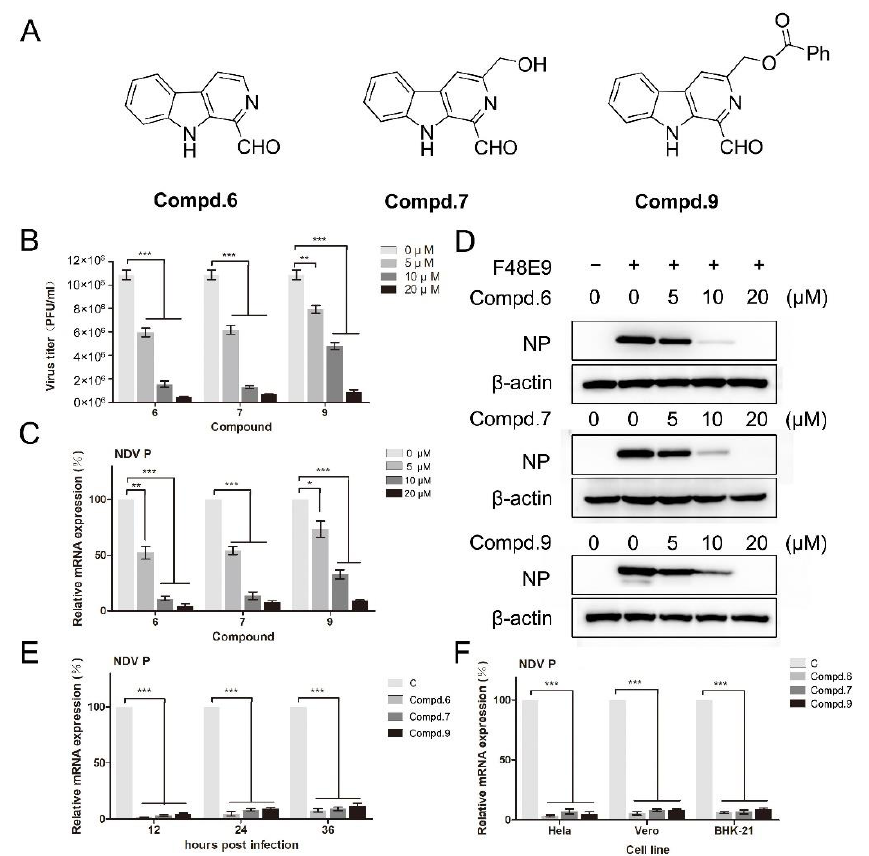
Figure 1. 1-formyl- β -carboline derivatives inhibit the NDV proliferation in a dose-dependent manner. ( A ) Molecular structures of compounds 6 , 7 , and 9 . ( B – D ) DF-1 cells were infected with F48E9 (MOI = 0.01). After adsorption (1 h), cells were covered with DMEM containing different concentrations of each compound. At 24 h post-infection, the virus yield in the supernatant was measured by plaque assay ( B ). The relative mRNA expression was measured by RT-qPCR. ( C ). Protein levels were measured by Western blot ( D ). ( E ) DF-1 cells, infected with F48E9 (MOI = 0.01), were treated with each compound (20 µ M). At the indicated time point, cells were harvested to determine the viral mRNA expression by RT-qPCR. ( F ) Hela, Vero, and BHK-21 cells were infected with F48E9 (MOI = 0.01) and treated with each compound (20 µ M), respectively. At 24 h post-infection, cells were harvested to determine the viral mRNA expression by RT-qPCR. The data represent the mean ± SD of three independent experiments. The statistical significance was analyzed using a two-tailed Student’s t -test: * p < 0.05; ** p < 0.01; *** p <